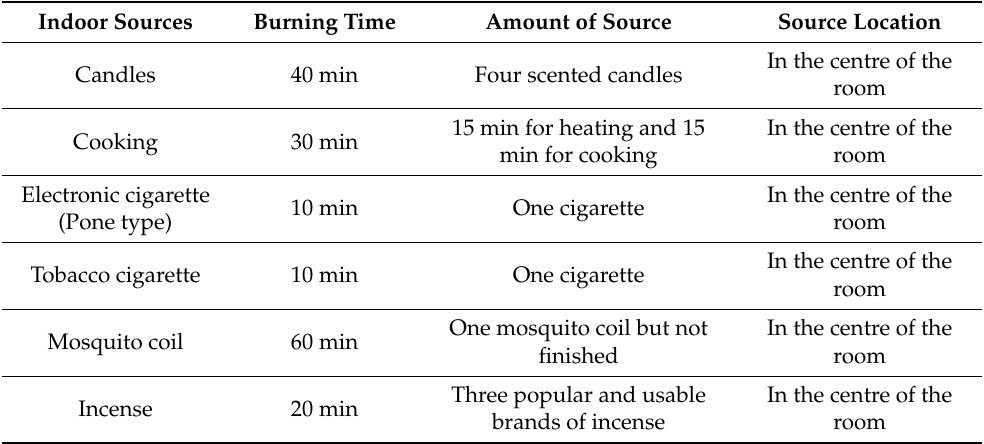
Table 1. Description of the six different types for indoor aerosol sources. Indoor